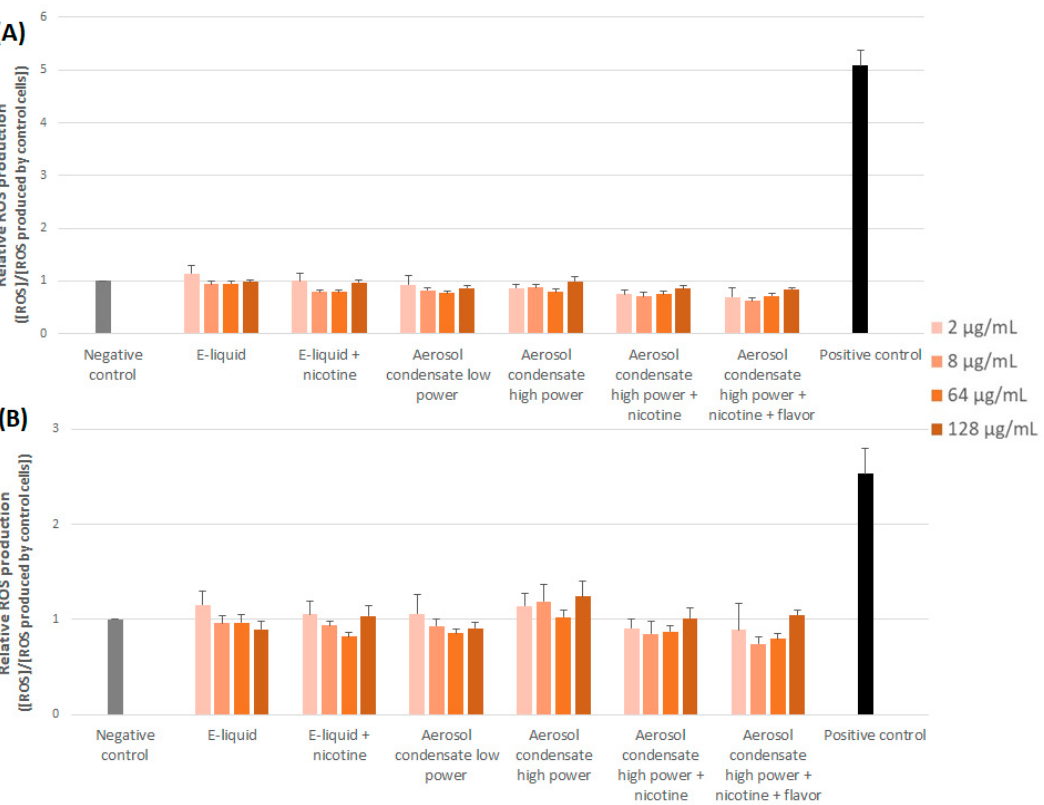
Figure 3. Relative ROS production induced by the different experimental conditions and assessed after 90 min ( A ) or 24 h ( B ) of cell exposure. Results are expressed relative to control (unexposed) cells and are means of three independent experiments, each performed in duplicate.